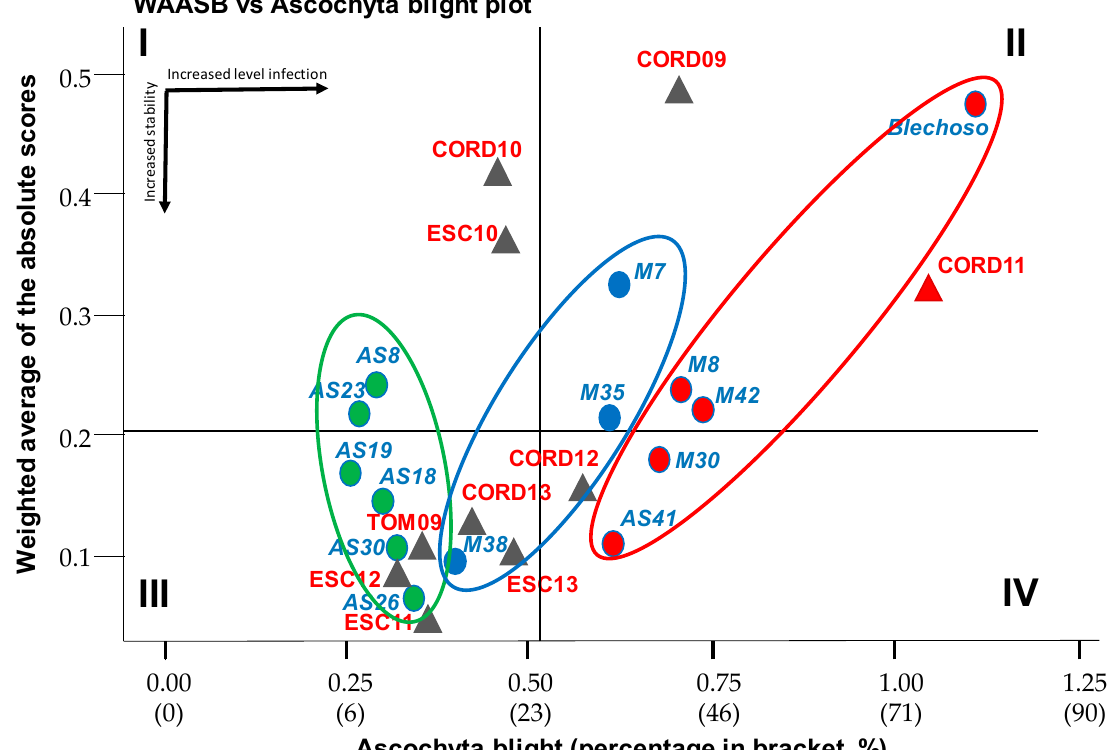
Figure 2. Biplot of ascochyta blight vs. WAASB of 14 chickpea genotypes evaluated in 10 environ- ments. Horizontal black arrows indicate the direction of the increase in level ascochyta infection; vertical arrow indicate increase of stability. Triangle for environments and circle with different colors for genotypes. Groups of genotypes with similar performance regarding stability and performance in ellipses according to cluster analysis of the ranking matrix from the 50/50 to the 0/100 scenarios for the WAASB/GY ratio.